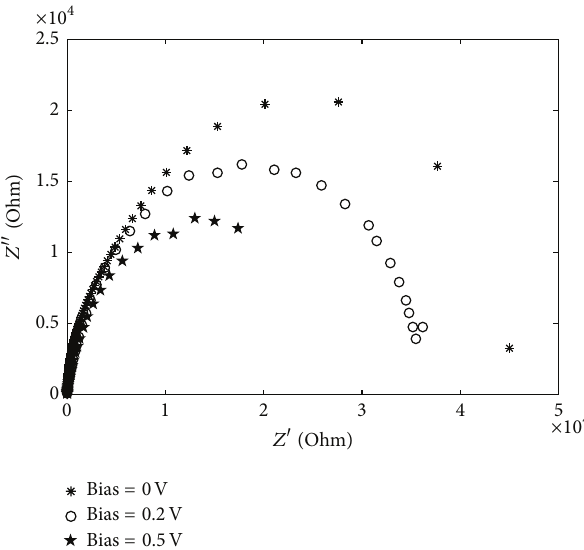
Figure 6: Impedance spectra of LCPV module under forward bias conditions.